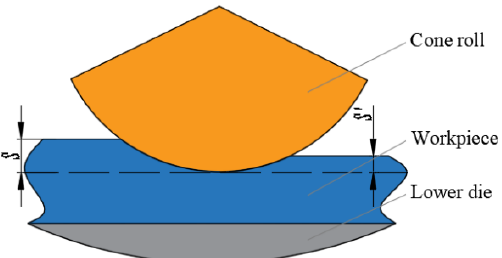
Figure 1. Schematic diagram of rotary forging.